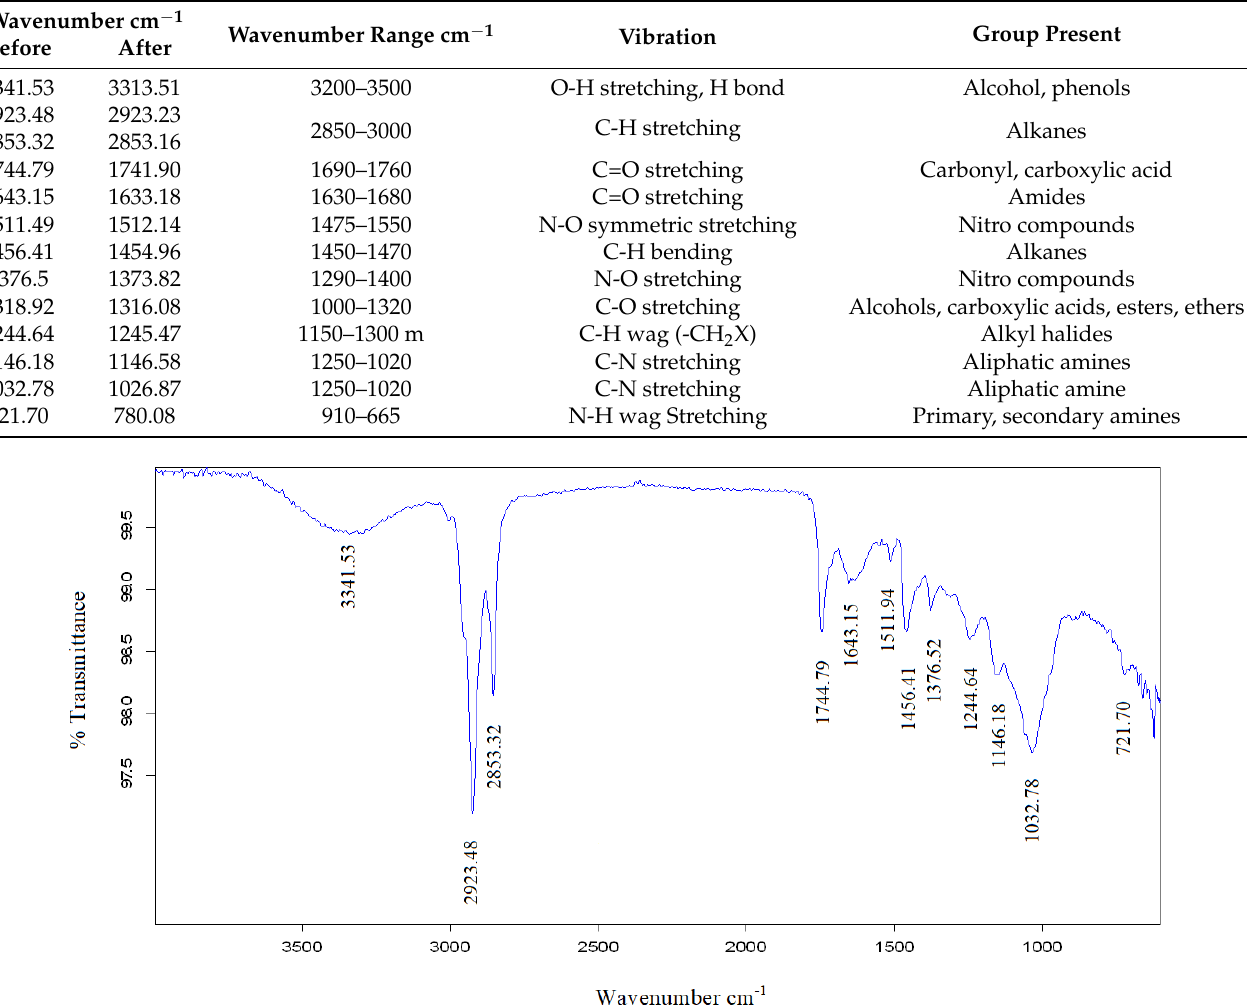
Table 2. FTIR spectrum of ASs adsorbents before and after adsorption process of oil.